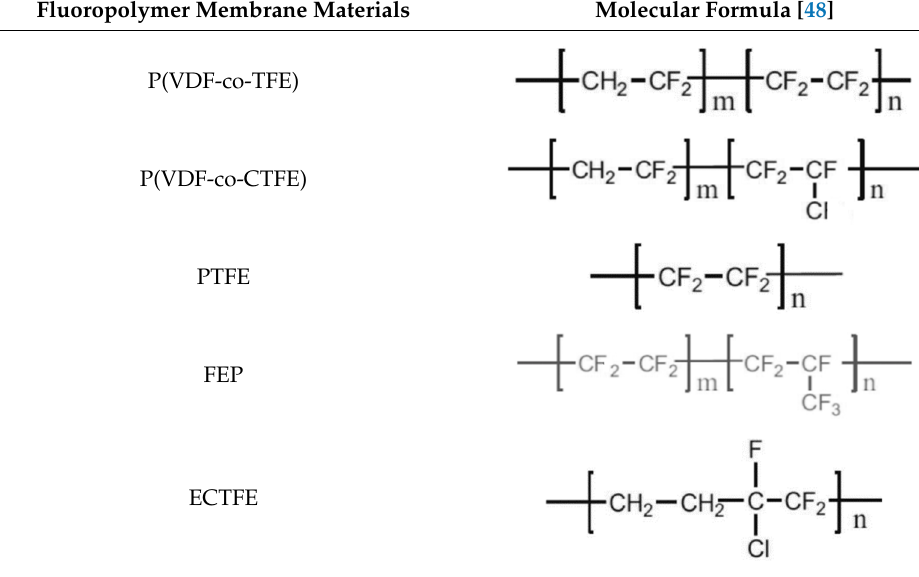
Table 2. Molecular formula of the most used hydrophobic fluoropolymer materials for MD and MCr.